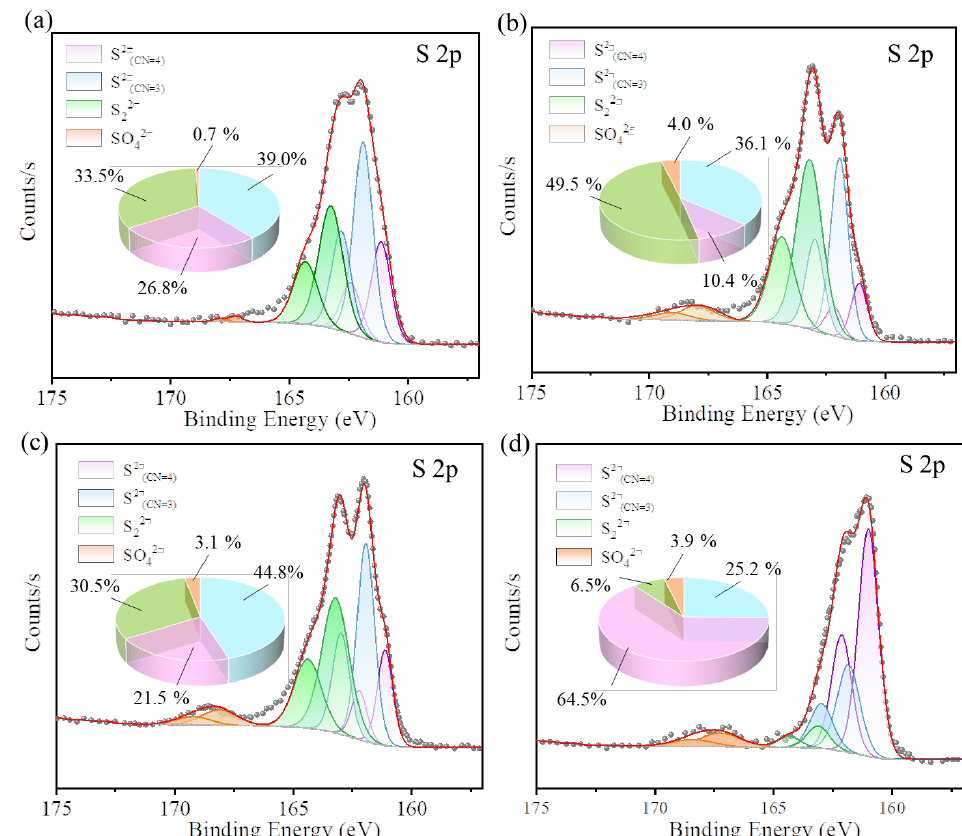
Figure 9. XPS spectra of S 2p for c-CuS under ( a ) N 2 , ( b ) 6% vol SO 2 , ( c ) 6% vol SO 2 + 6% vol O 2 , ( d ) 6% vol SO 2 + 6% vol O 2 +Hg 0 (Experimental condition: solution volume = 80 mL, solution pH = 3.0, solution temperature = 20 °C, the inlet concentration of Hg 0 was 200 µg·m −3 ).